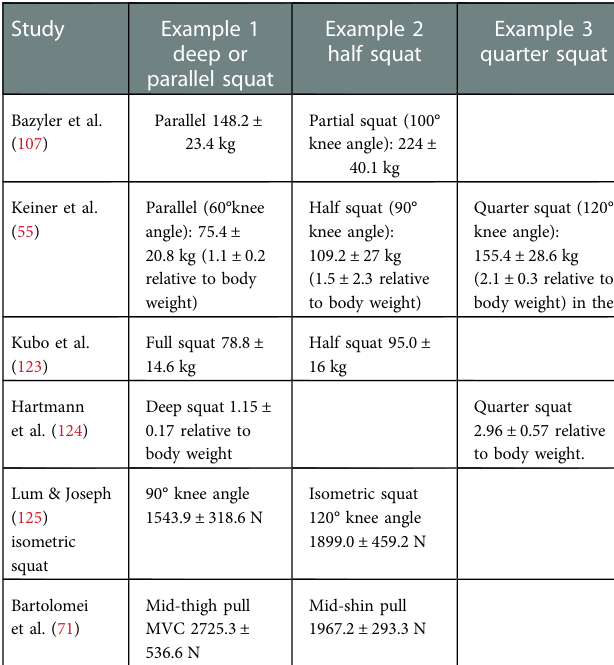
TABLE 3 Examples of angle speci fi city of squat force output